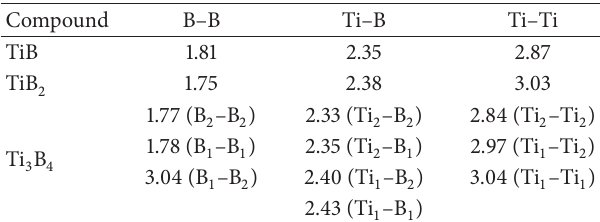
Table 2: Interatomic distances (in ˚A) for titanium